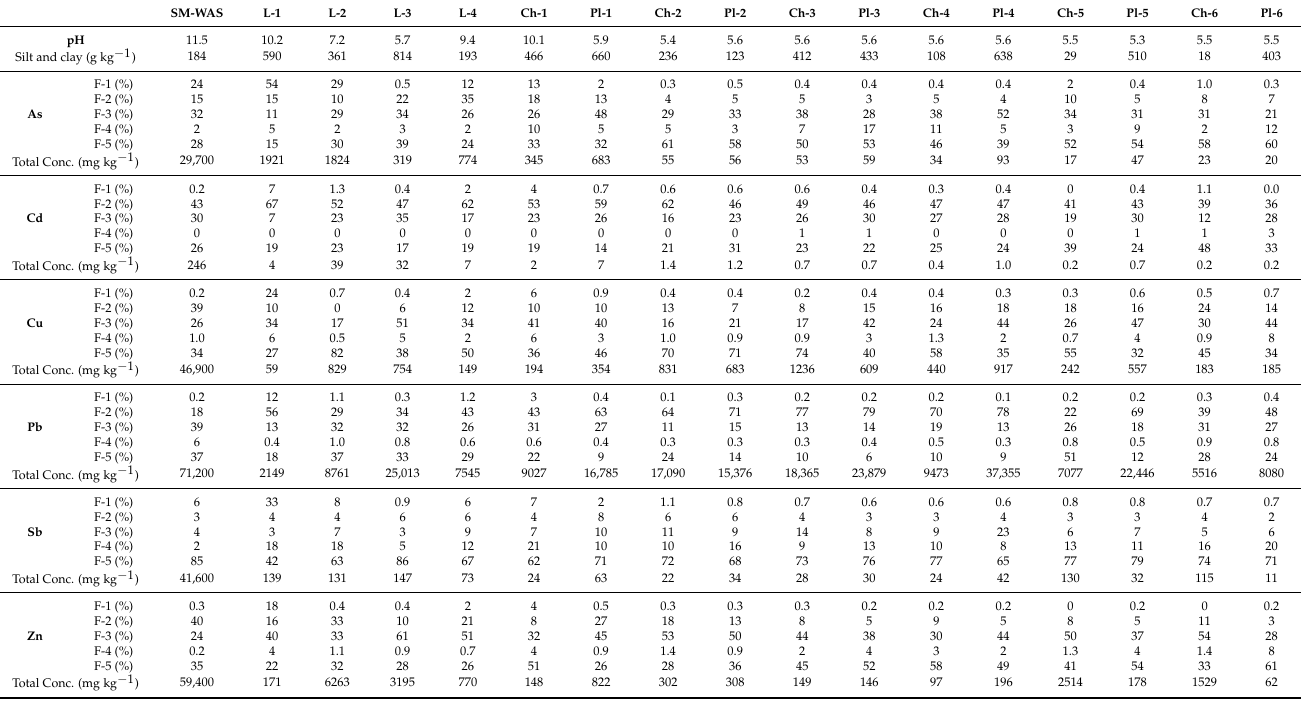
Table 3. The pH, silt-clay content, fractional and total concentrations of As, Cd, Cu, Pb, Sb and Zn in the facility waste (SM-WAS), floodplain (Pl-1 to Pl-6) and channel (Ch-1 to Ch-6) of Baños Creek. SM-WAS